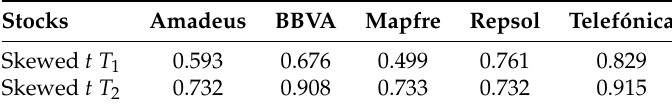
Figure 2. Plots of the theoretical cdfs of the skewed t models (LEFT: T 1 model; RIGHT: T 2 model) and the empirical cdf. Stocks: Amadeus; BBVA. Table 4. Bootstrap p -values for both models and all five datasets.